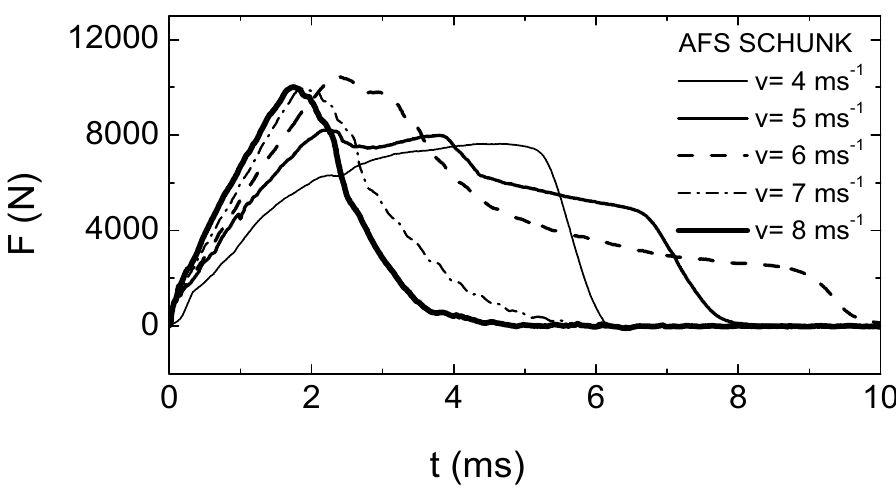
Figure 8. Load-time curves ( AFS Schunk ).